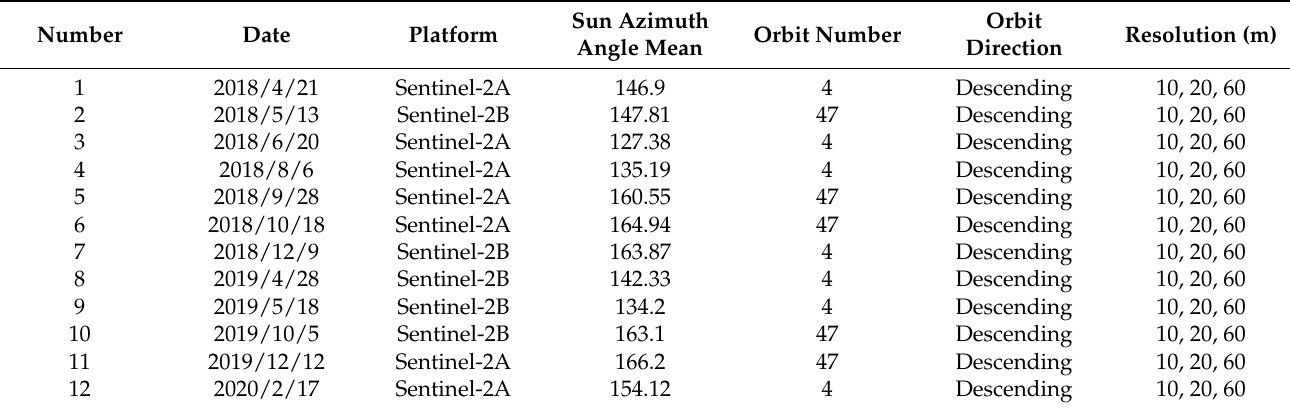
Table 2. Sentinel-2 data parameters.